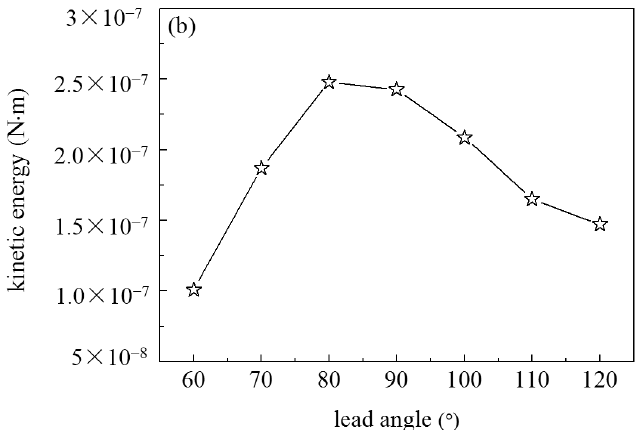
Figure 6. Initial velocity of the jet ( a ) and kinetic energy of the droplet ( b ) as a function of the lead angle respectively.